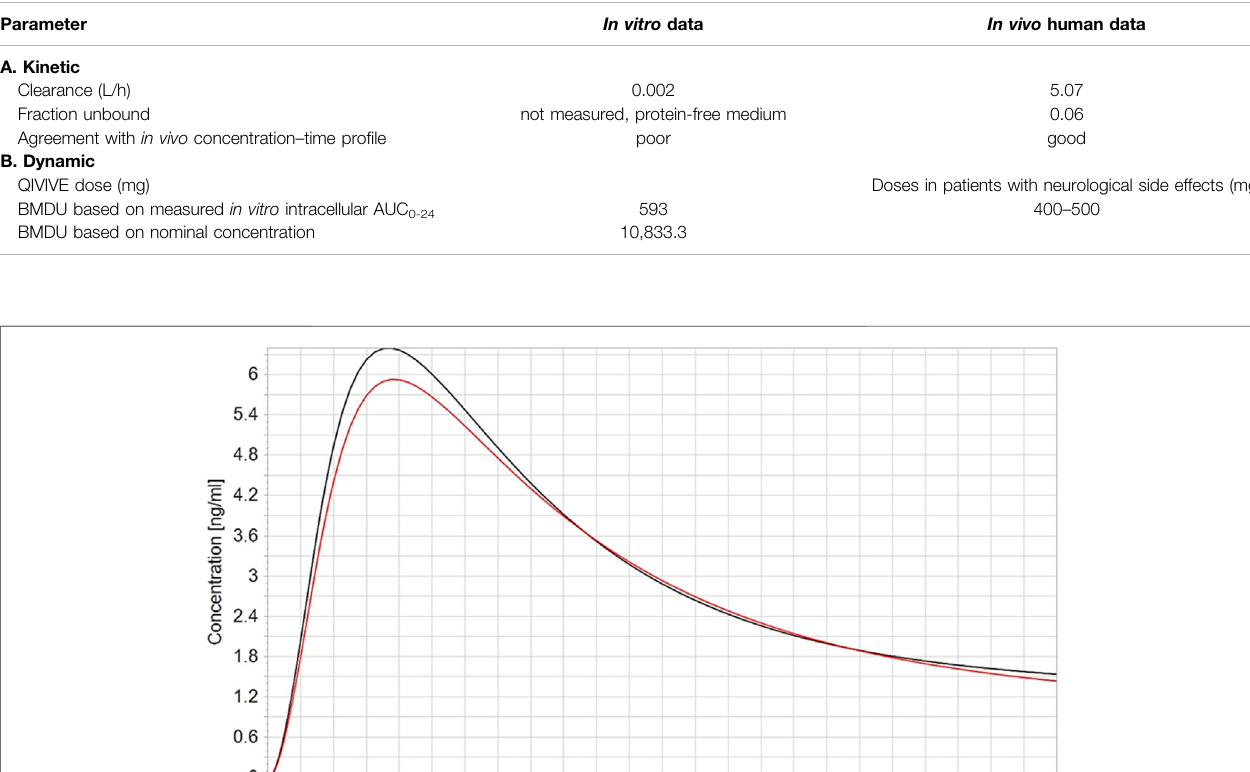
Frontiers in Toxicology |